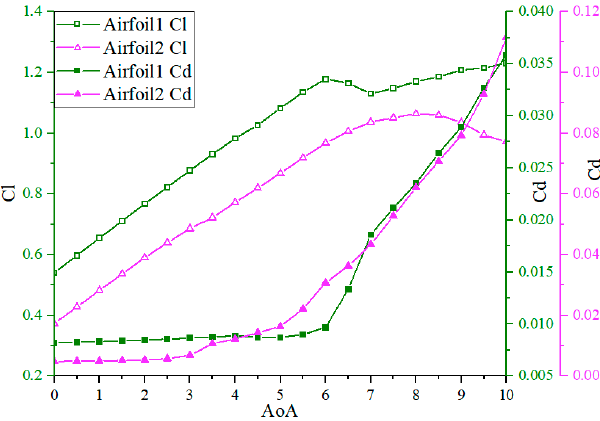
Figure 13. Lift and drag of the new airfoil.